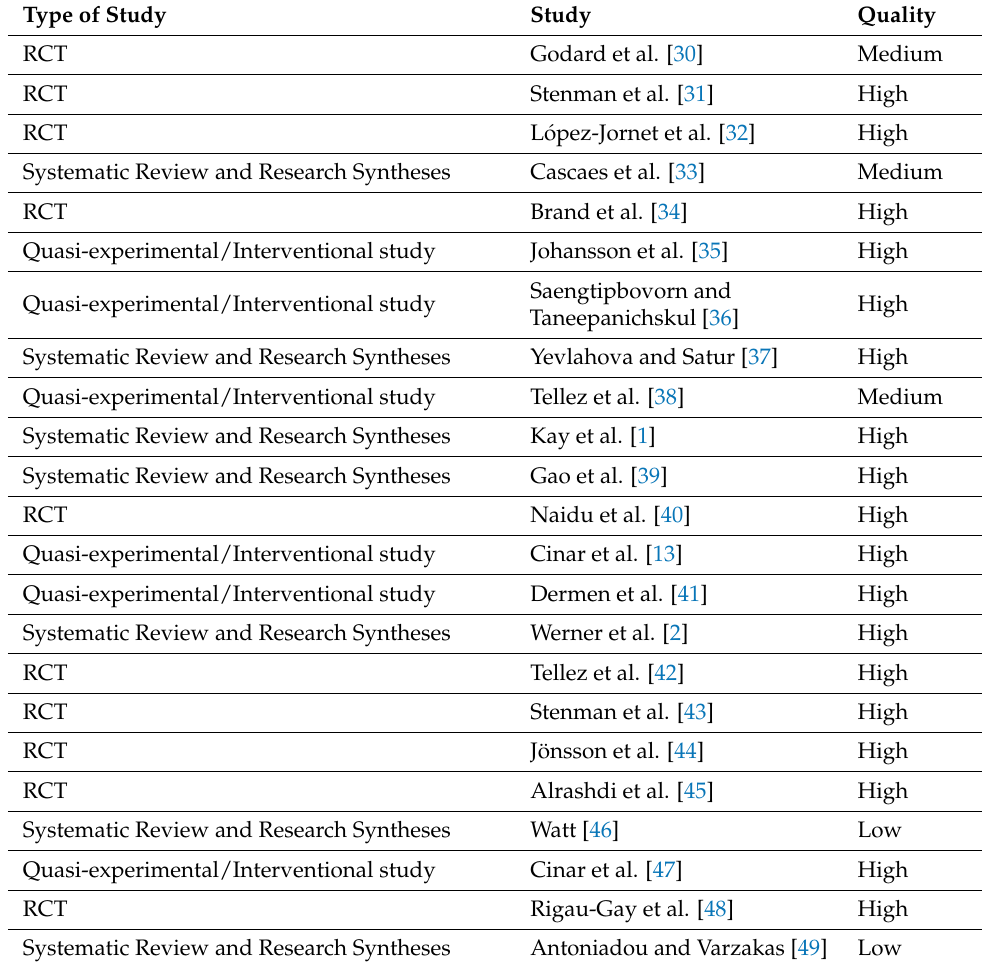
Table 3. Quality assessment results of the included